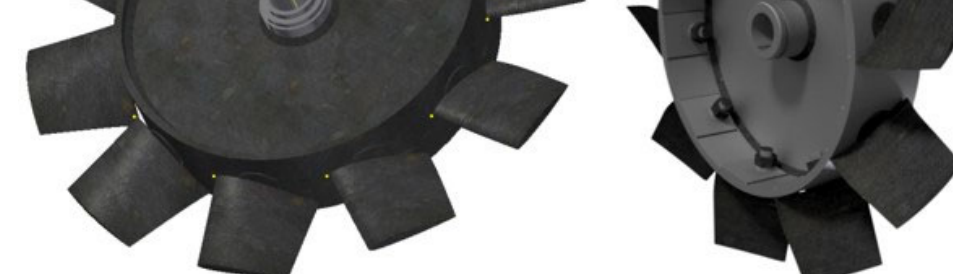
Figure 8. The model of the rotor prepared for analysis.